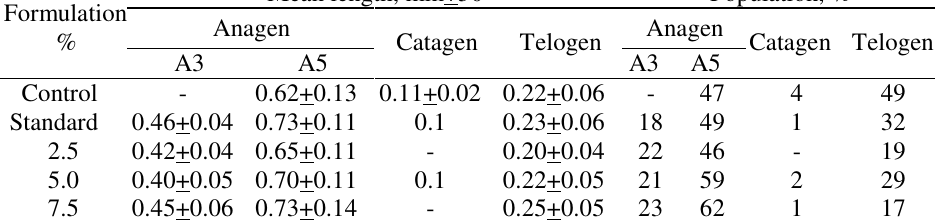
Table 5 . The rate of hair